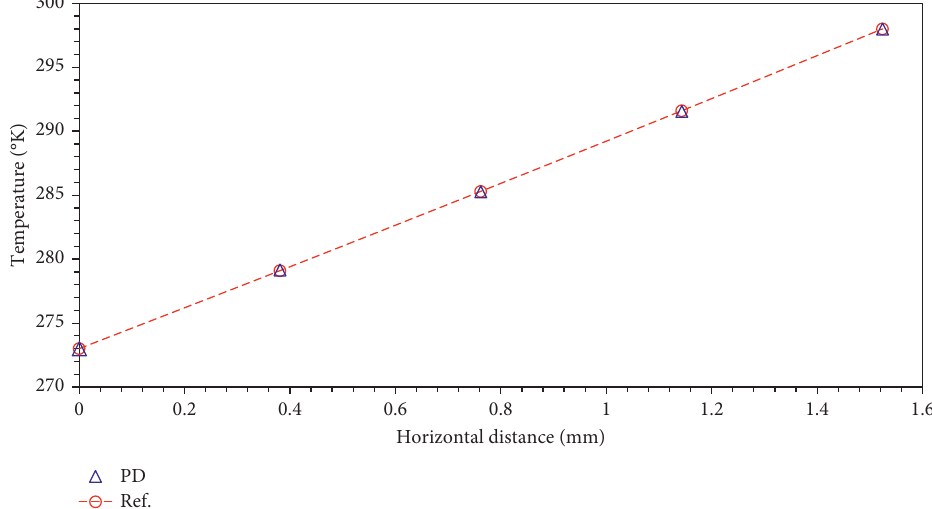
Figure 18: Comparison of temperature values from PD and [90].